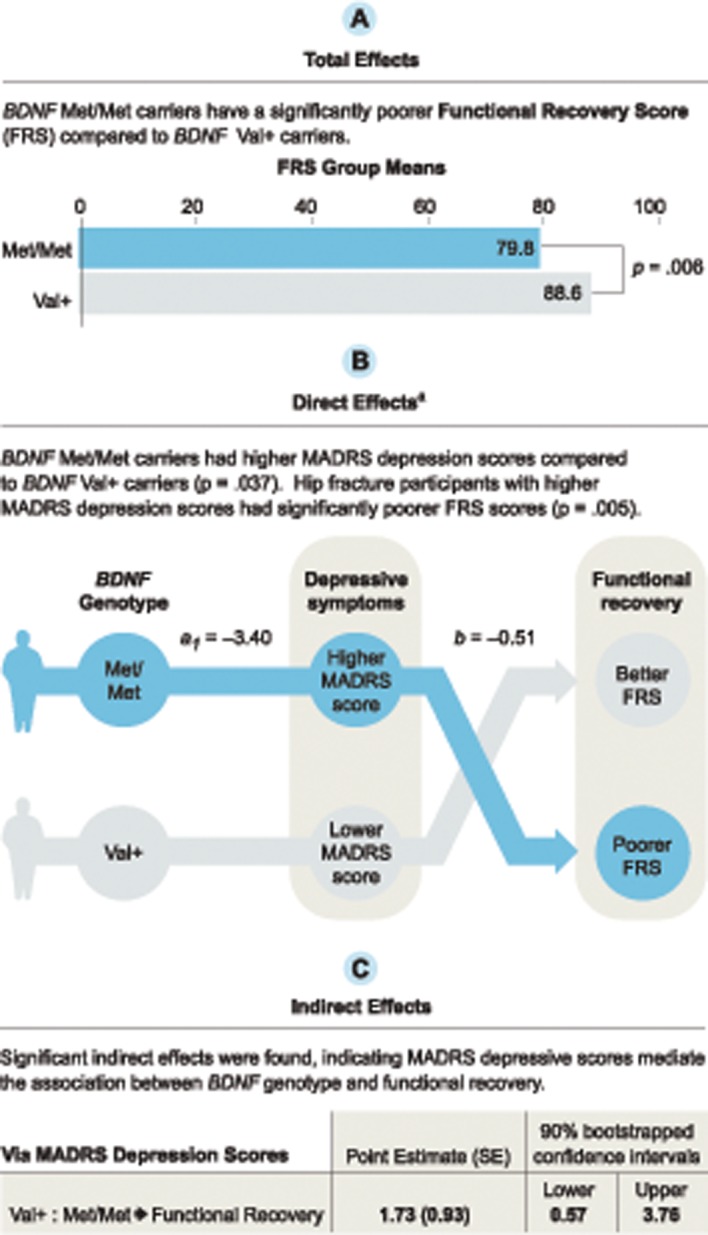
Mediation model using Hayes’ (2013) multicategorical independent variable method. Mediation test of the relationship between brain-derived neurotrophic factor (BDNF) Val66Met polymorphism and the Functional Recovery Score (FRS) at week 12 as a result of the Montgomery-Asberg Depression Rating Scale (MADRS) depression scores. Results are shown for the BDNF Val+:Met/Met contrast. The Val/Val:Val/Met contrast was not significant.